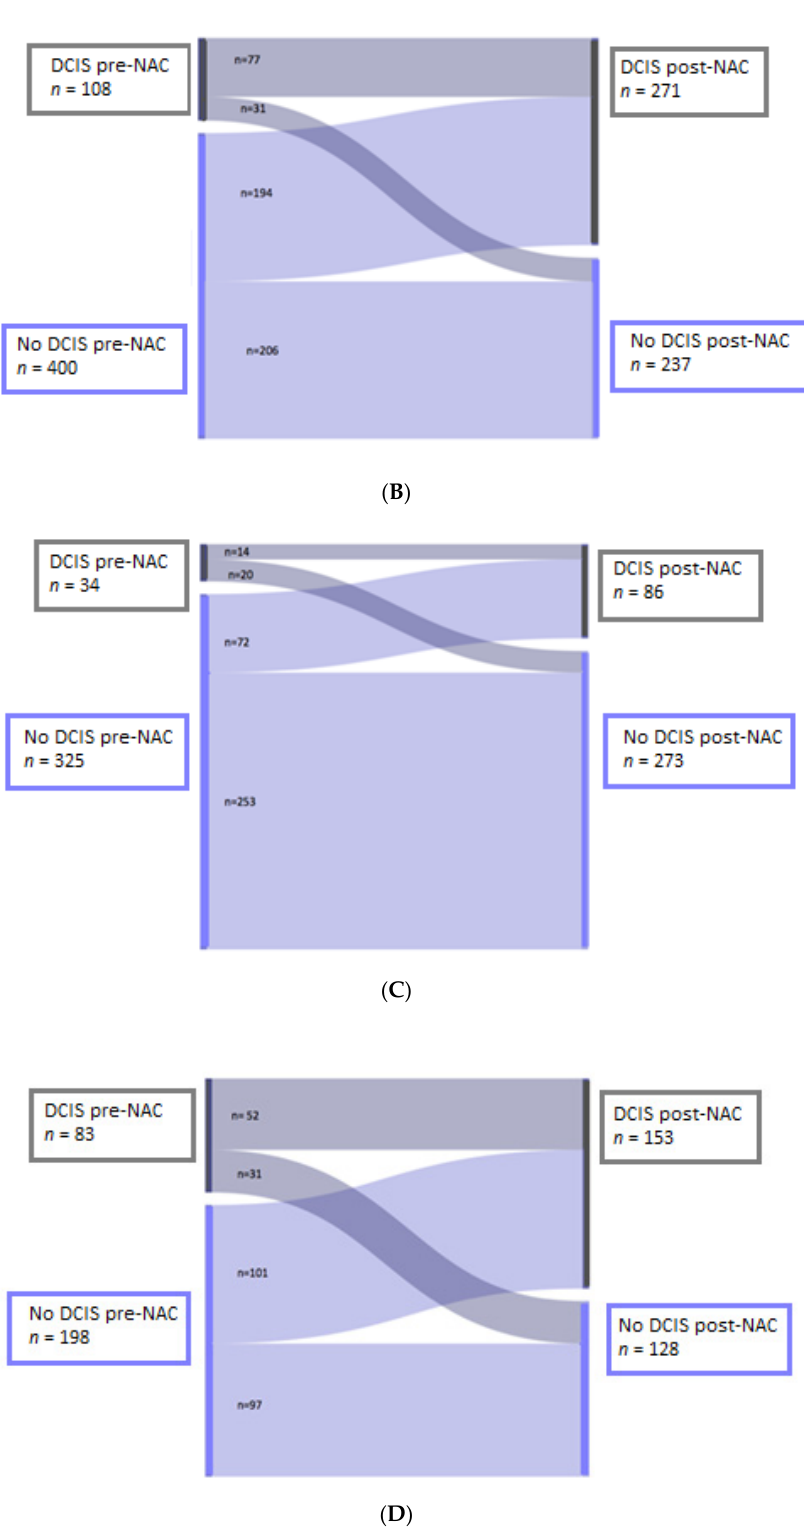
Figure 3. Presence of ductal carcinoma in situ (DCIS) component before and after neaoadjuvant chemotherapy (NAC) ( A ) Presence of DCIS before and after NAC, for the total population (1148 patients). ( B ) Presence of DCIS before and after NAC for luminal BC (508 patients). ( C ) Presence of DCIS before and after NAC for TNBC (359 patients). ( D ) Presence of DCIS before and after NAC for HER2 -positive BC (281 patients). Abbreviations: ductal carcinoma in situ (DCIS), neoadjuvant chemotherapy